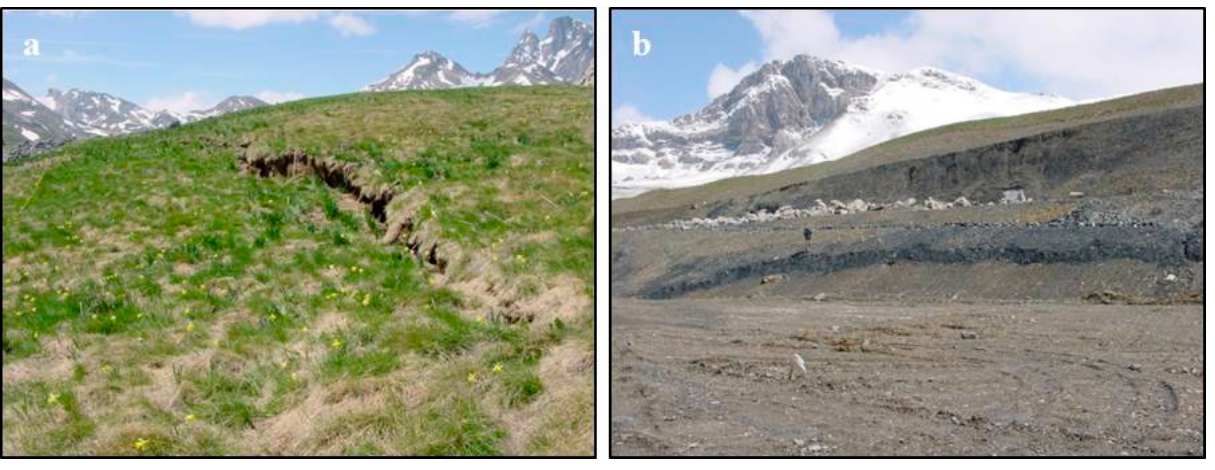
Figure 7. Inclinometers records: ( a ) Inclinometer placed in borehole B-5, reprinted with permission from ref. [15], Copyright Year 2005, Copyright Owner’s F.J. Torrijo (old geotechnical investigations [15], conducted in 2005); ( b ) Inclinometer placed in borehole B-9 (new geotechnical investigations, conducted in 2016). Topographical works developed during the previous investigation [15] detected the existence of three main landslides in the area under study (landslides, 1, 2 and 3 in Figure